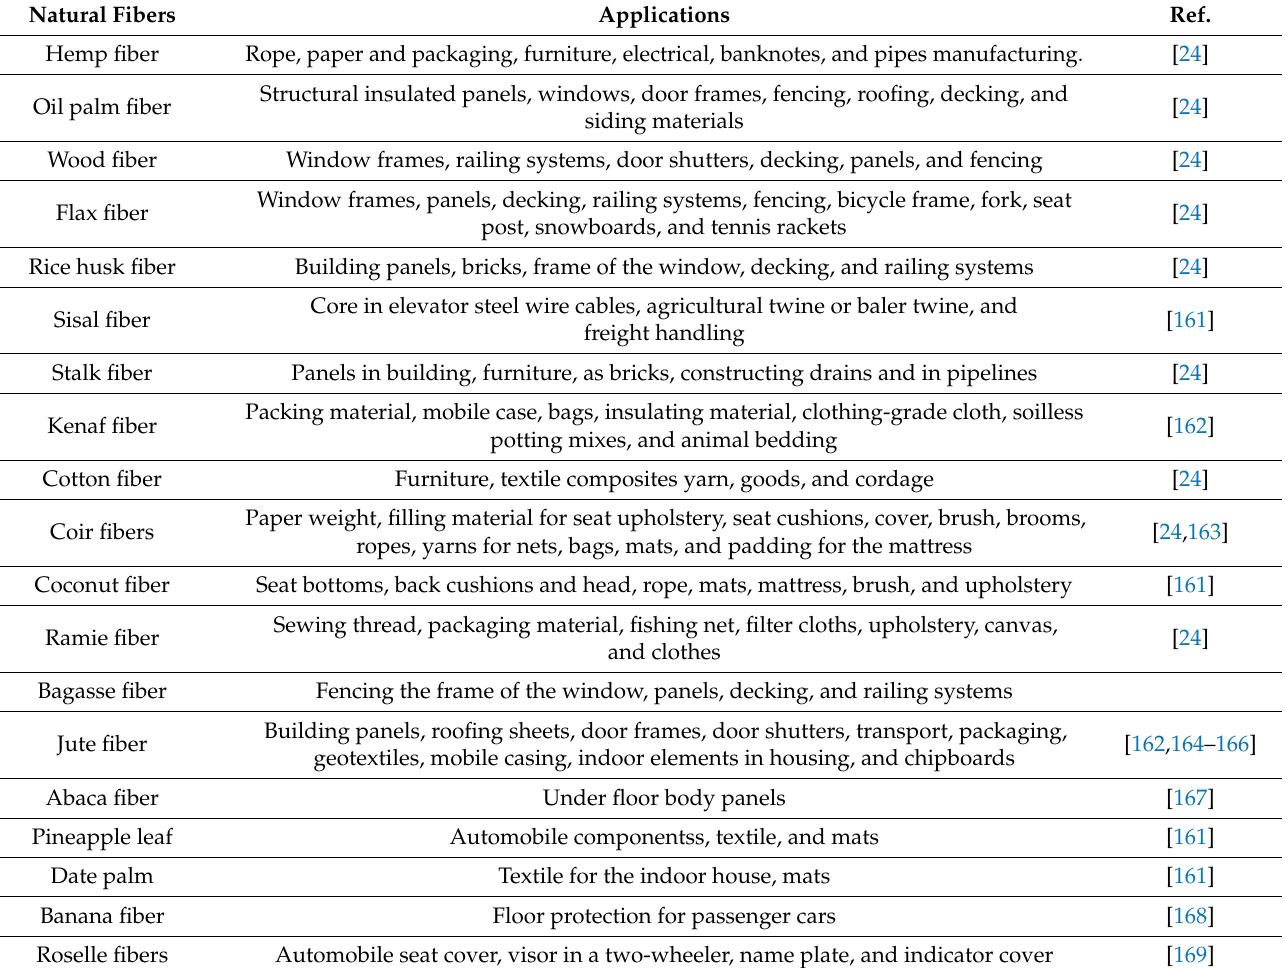
Table 6. Natural fibers and their constructions and automotive